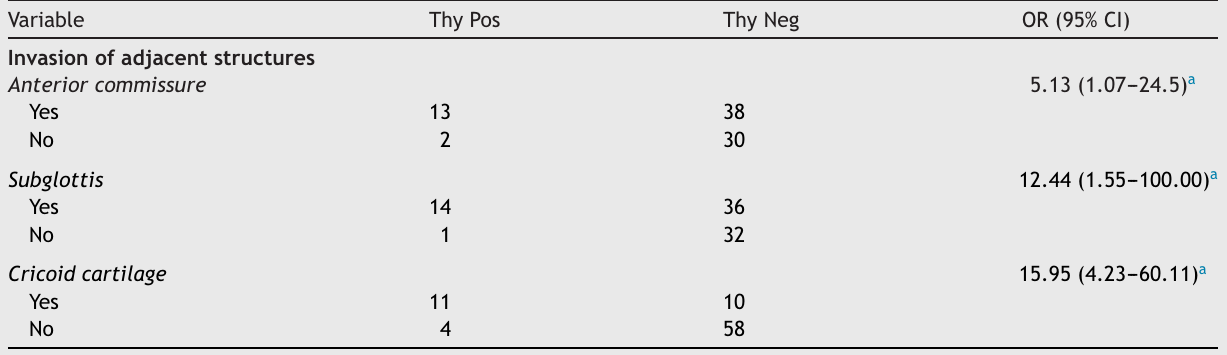
Table 5 Association between thyroid gland invasion by SCC and anatomopathological data --- odds ratio and 95% confidence